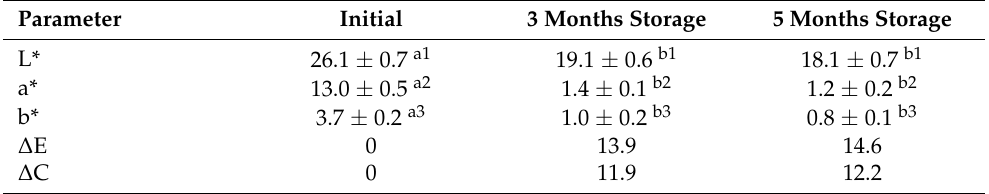
Table 8. Color parameters (L*, a*, and b*), cumulative difference in color ( ∆ E) and color intensity ( ∆ C) of pomegranate juice that was treated for 10 min at 80 ◦ C and stored at 18 ◦ C. Parameter